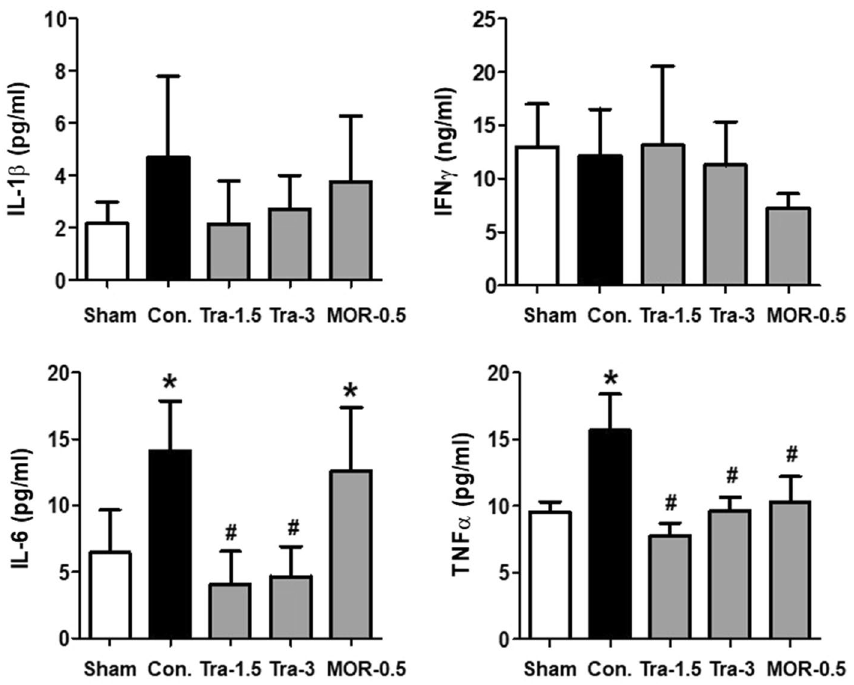
Figure 5. Serum ELISA for MCF-7 tumor-bearing nude mice. Nude mouse serum levels of TNF-α, IFN-γ, IL-6, and IL-1β were measured by ELISA. Sham, healthy mice not bearing cancer; control group; Tra-1.5, tramadol 1.5 mg kg −1 day −1 ; Tra-3, tramadol 3 mg kg −1 day −1 ; MOR-0.5, morphine 0.5 mg kg −1 day −1 . *p < 0.05 vs . Sham, # p < 0.05 vs. Con. MCF, Michigan cancer foundation; TNF; tumor necrosis factor, IFN; interferon, IL; interleukin, ELISA; enzyme-linked immunosorbent